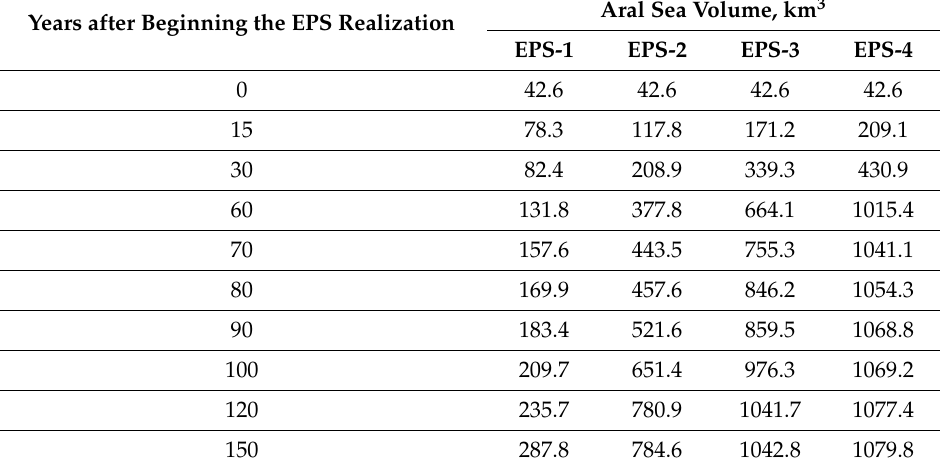
Table 4. The Aral Sea recovery dynamics depending on the area of natural evaporators.